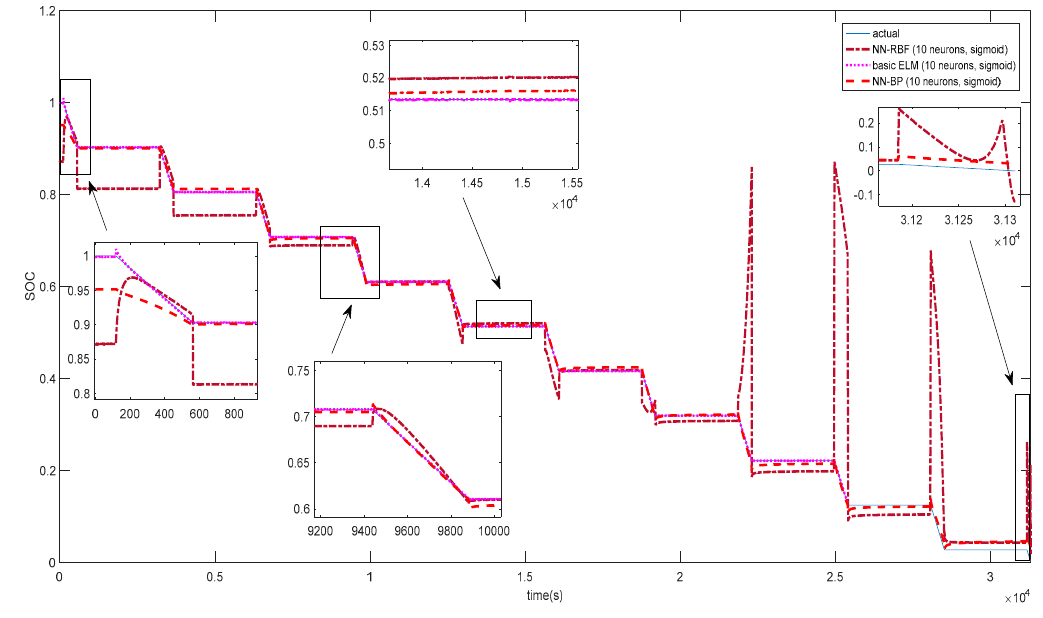
Figure 11. Different number of neurons used in BP, RBF, and ELM.